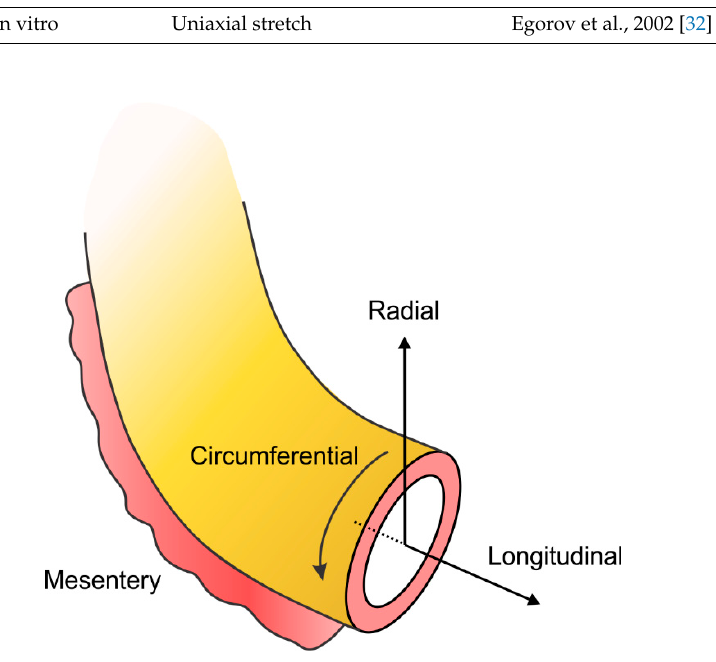
Figure 2. Schematic diagram showing the cylindrical coordinates of the large intestine in circumferential, radial, and longitudinal directions. Table 1. Mechanical tests on large intestinal tissues.